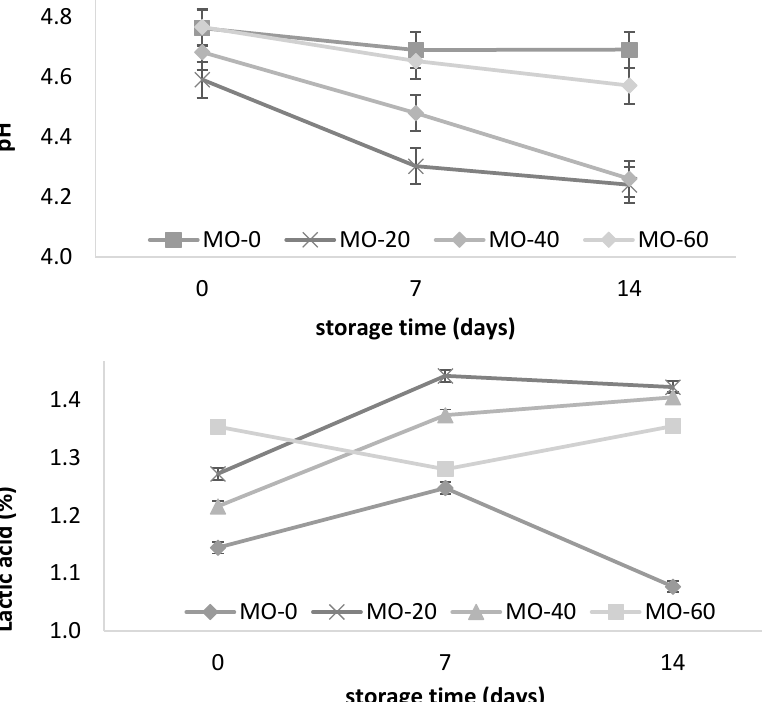
Figure 1. Storage changes in pH and acidity of yogurt from sheep fed with Moringa oleifera extracts. Bars denote standard error of the means.